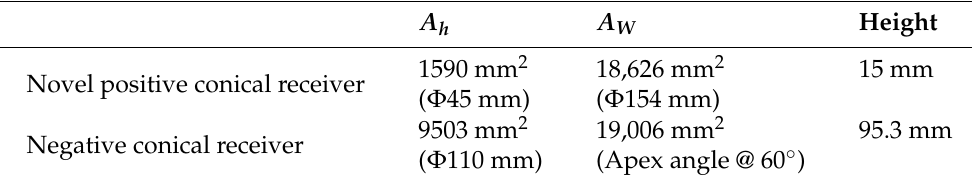
Table 1. Cavity dimensions for analytical